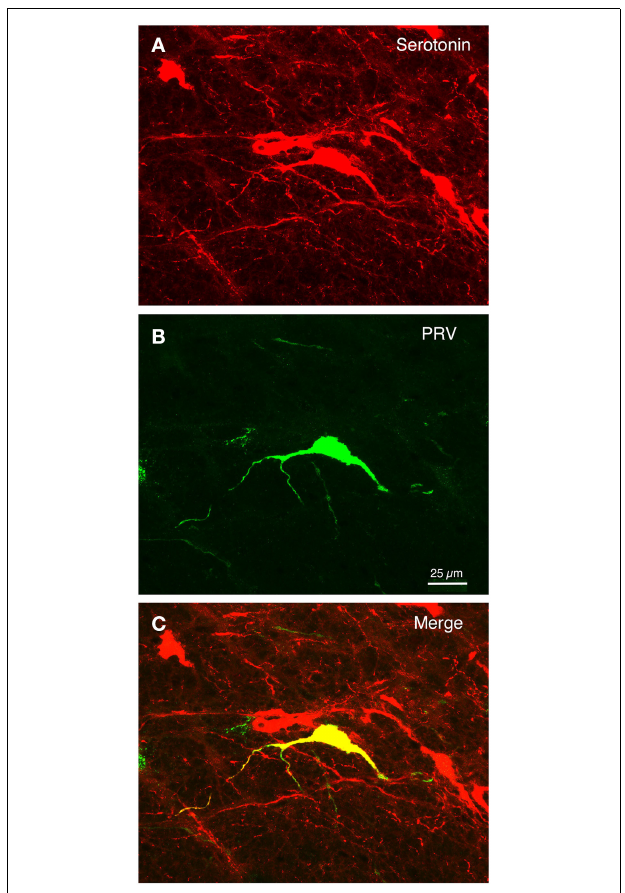
FIGURE 9 | The isolated PRV + neurons of the B3 pontine midline region that were labeled by choroidal injection typically co-contained serotonin. (A–C) Show a high power view of serotonergic neurons (red) in the RaM region (A) , one neuron of which was labeled with PRV (green) (B) , as shown in the merged image (yellow) (C) . Scale is the same in all